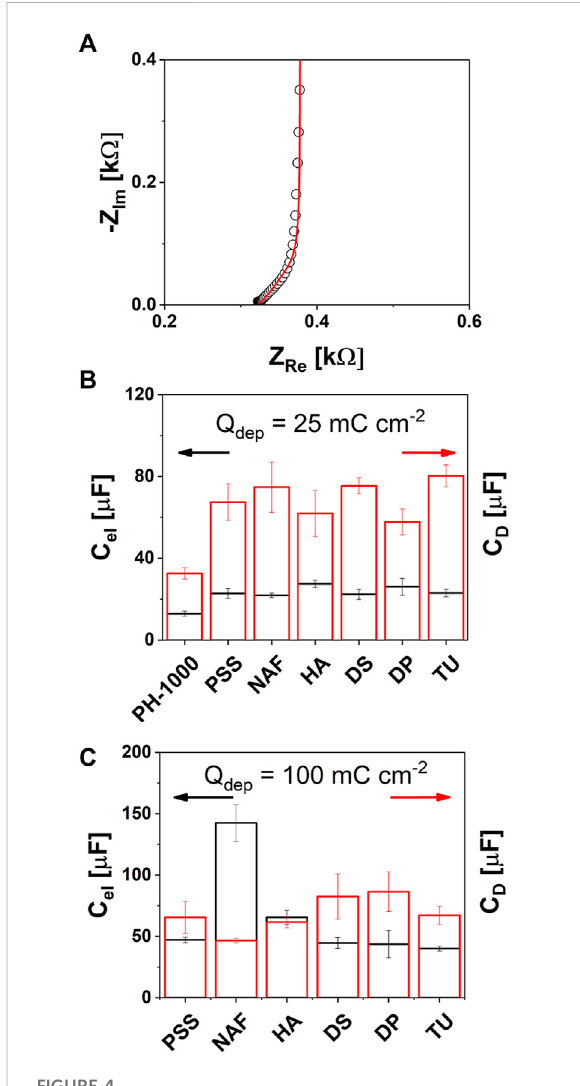
FIGURE 4 EIS analysis: (A) typical complex plane (Nyquist) plot showing the high frequency 45 ° line of the Warburg diffusion element Z D (experimental and calculated impedance values were reported as black circles or red line, respectively); (B) and (C) electronic C el (black) and diffusional capacitance C D values extracted by the EIS fi tting for PH-1000 and PEDOT/X at 25 or 100 mC cm − 2 of deposition charge, respectively (mean values ± std, n =